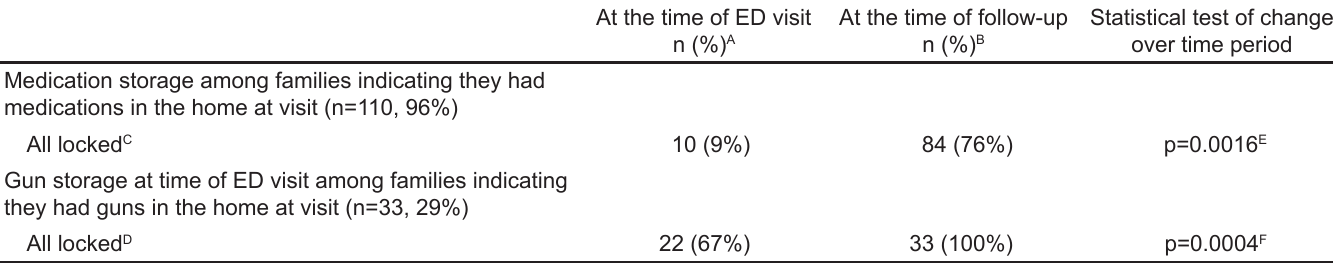
Table 2. Comparison of medication and gun storage behavior reported by parents at time of visit and in follow-up interview among those completing a follow-up interview